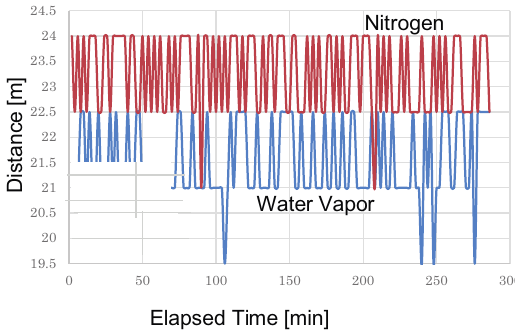
Fig. 6 Peak motions on the atmospheric nitrogen and the water vapor echoes in